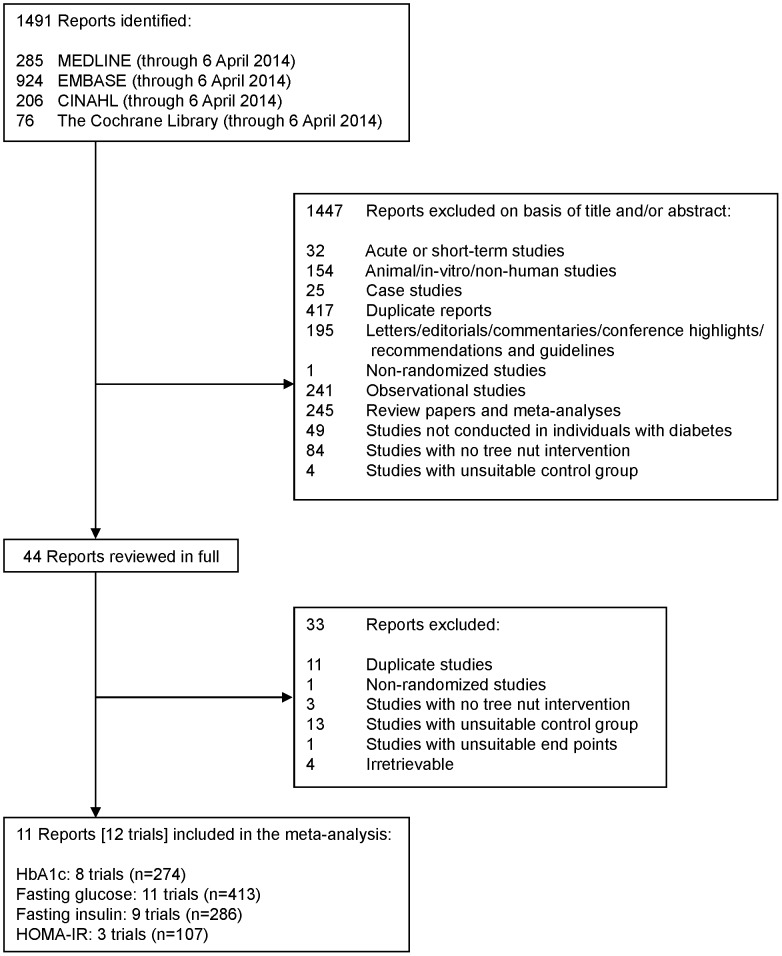
Flow of the literature.Summary of search and selection process consists of the number of studies initially identified through database and manual search, excluded based on title and abstract, reviewed in full, excluded after full review, and final number of trials included in the meta-analysis.